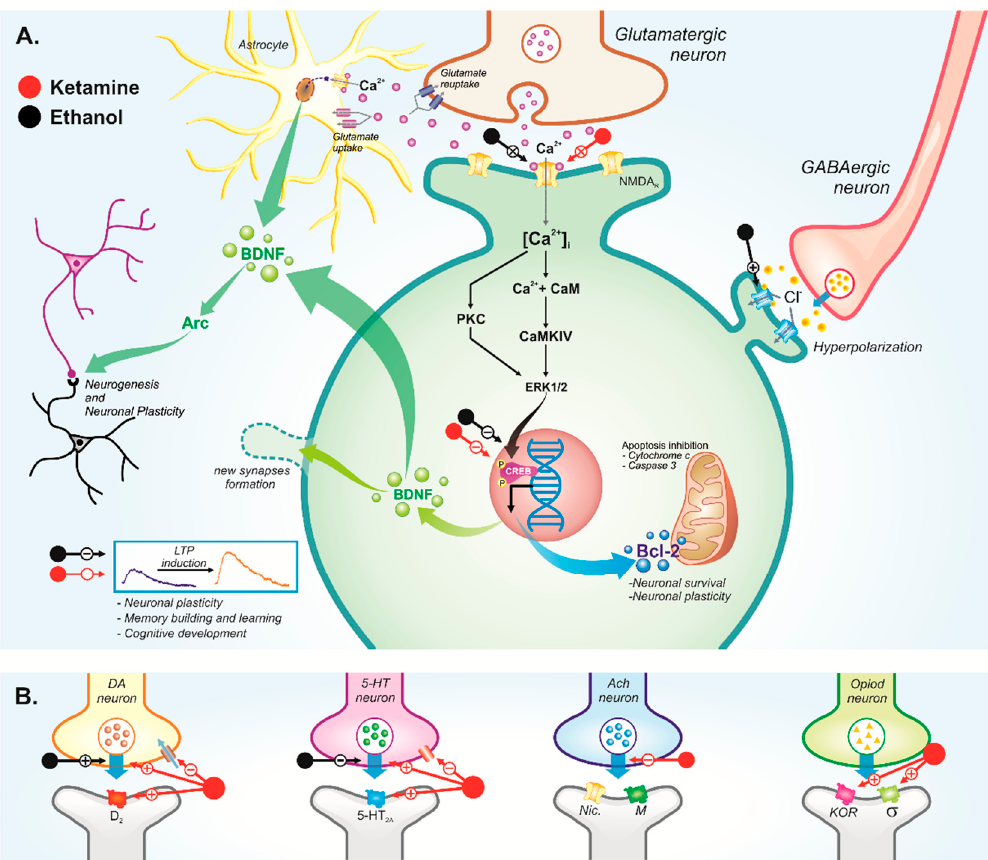
Figure 2. Principal pharmacological mechanisms and repercussions of ketamine (red markers) or ethanol (black markers) use during drugs bioavailability on ( A ) glutamatergic, GABAergic, ( B ) dopaminergic, serotoninergic, cholinergic, and opioidergic neurotransmission on the central nervous system. (+) Activation, elevation, potentiation, or stimulation; ( − ) inhibition or reduction; (X) blocking.